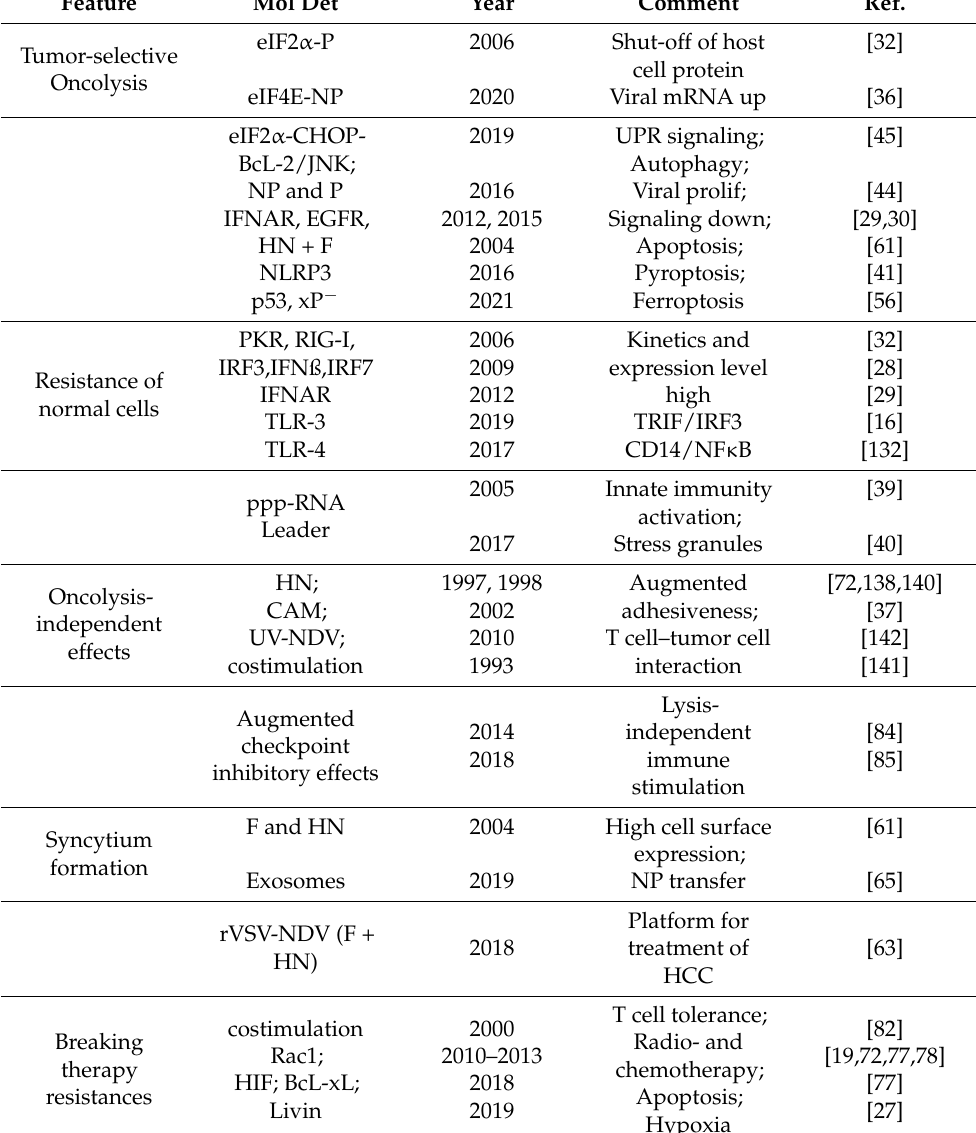
Table 1. NDV-mediated anti-neoplastic effects.